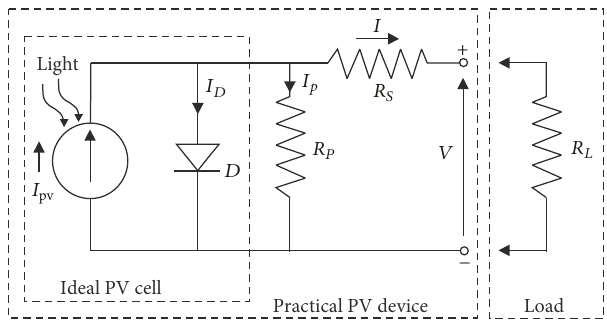
Figure 2: Equivalent model of a PV cell.